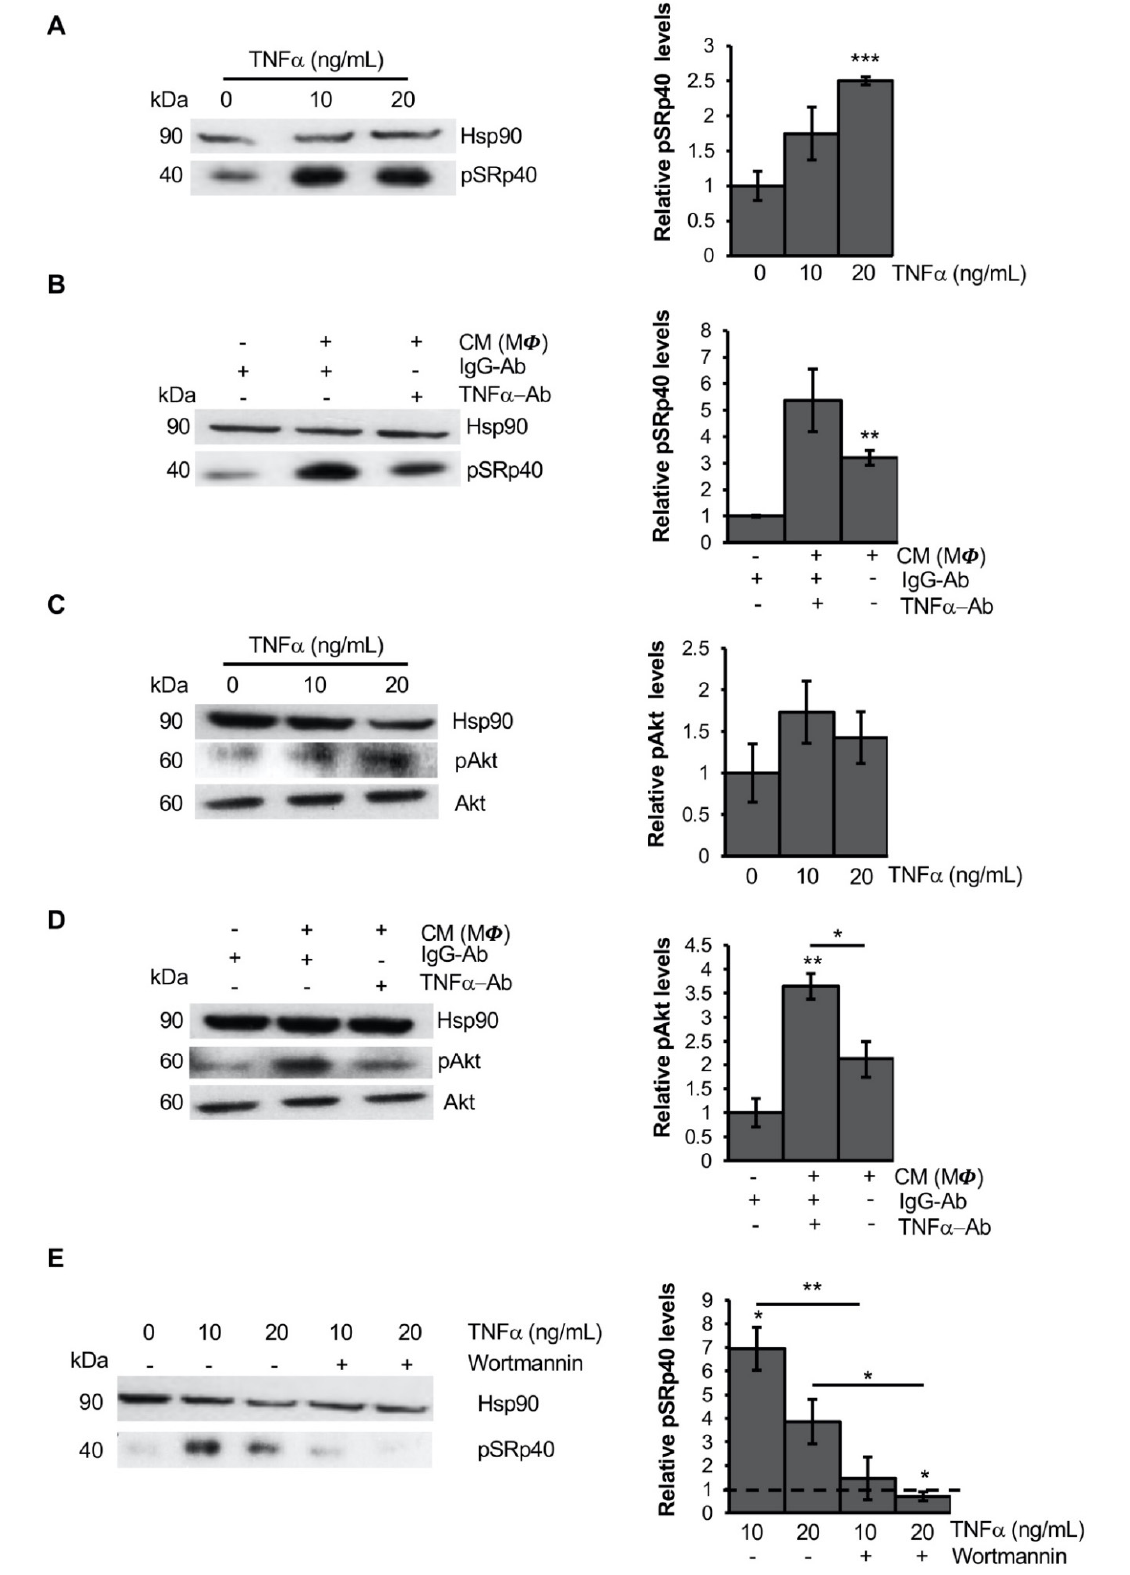
Figure 4. TNF α increases SRp40 phosphorylation through AKT: ( A ) Representative autoradiograph of Western blot analysis (left panel) of SRp40 phosphorylation (i.e., pSRp40) levels in hMSCSc at T = 0